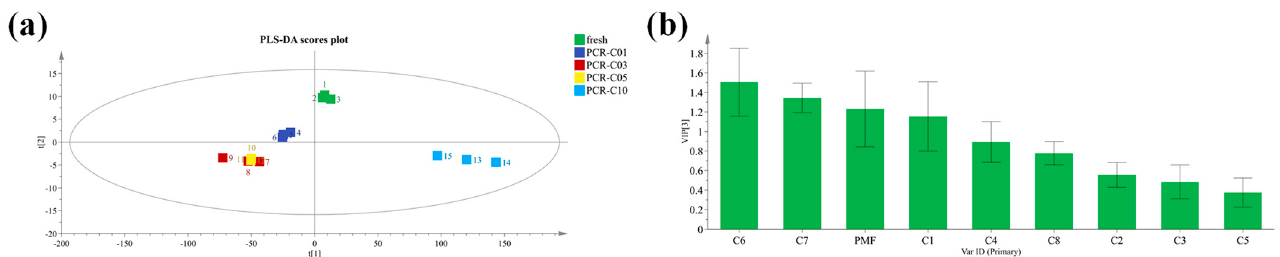
Figure 2. ( a ) PLS ‐ DA of PCR ‐ C samples and ( b ) variable importance in projection (VIP) score based Figure 2. ( a ) PLS-DA of PCR-C samples and ( b ) variable importance in projection (VIP) score based on the free PMFs in PCR ‐ C (Fresh, PCR ‐ C01, PCR ‐ C03, PCR ‐ C05, PCR ‐ C10). C1, isosinensetin; C2, on the free PMFs in PCR-C (Fresh, PCR-C01, PCR-C03, PCR-C05, PCR-C10). C1, isosinensetin; C2, sinensetin; C3, 5,7,8,4 ′‐ tetramethoxyflavone; C4, nobiletin; C5, 5,6,7,4 ′‐ tetramethoxyflavone; C6, sinensetin; C3, 5,7,8,4 (cid:48) -tetramethoxyflavone; C4, nobiletin; C5, 5,6,7,4 (cid:48) -tetramethoxyflavone; C6, 3,5,6,7,8,3 ′ ,4 ′‐ heptamethoxyflavone; C7, tangeretin; and C8, 5 ‐ demethylnobiletin. 3,5,6,7,8,3 (cid:48) ,4 (cid:48) -heptamethoxyflavone; C7, tangeretin; and C8,